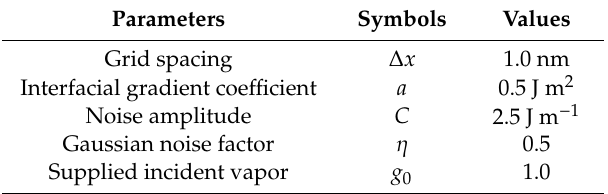
Table 1. List of the model and numerical parameters used in the present phase-field